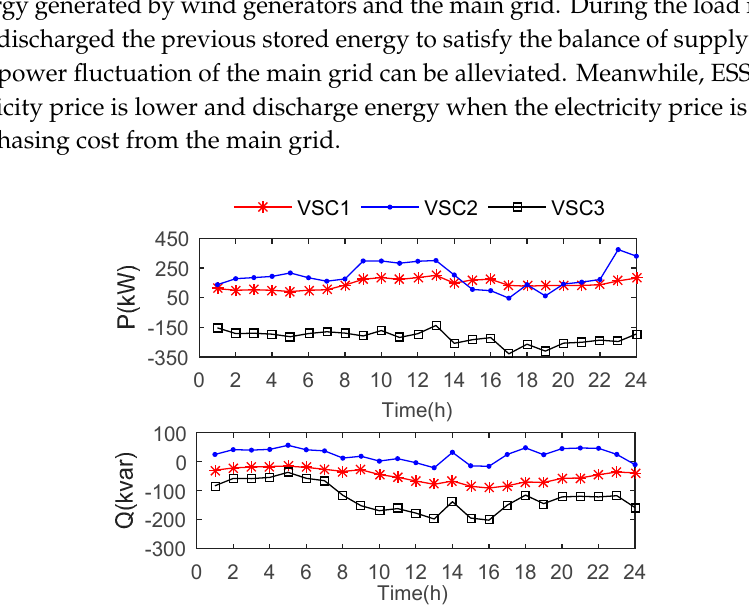
Figure 6. The transferred active and reactive power by VSC in Case 2.